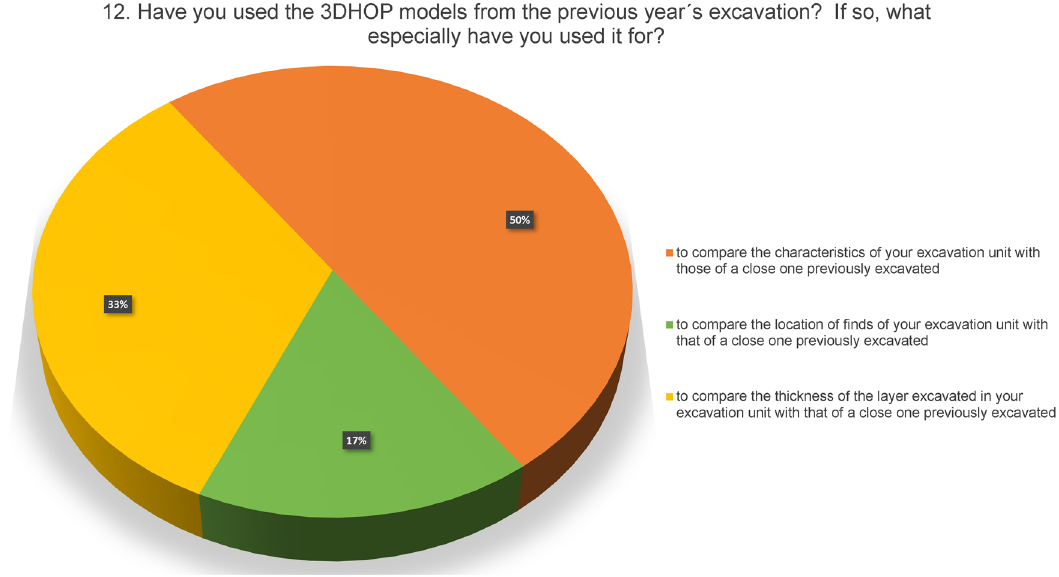
Figure 9: Question 12 illustrates its use for the visualisation of the models of the previous year ’ s